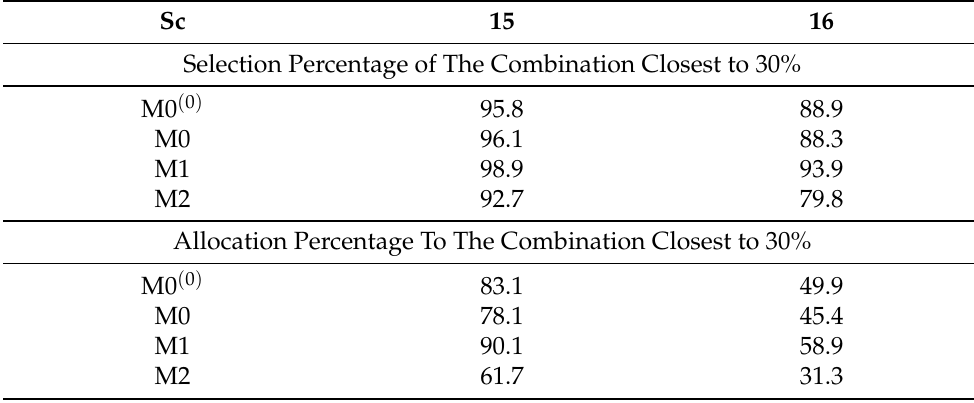
Table 5. Operating characteristics of the dose-finding designs under Scenarios 15 and 16. Results are based on 4000 simulations.